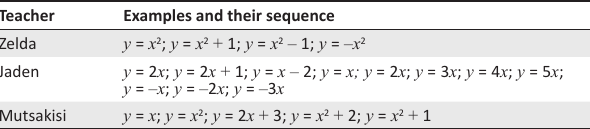
TABLE 8: Sequences of examples in Zelda’s, Jaden’s and Mutsakisi’s